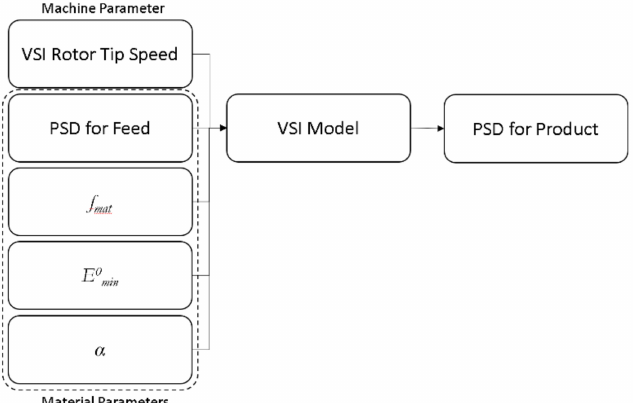
Figure 4. A model overview showing the parameters required to run the VSI crusher model at alternate speeds to predict the product PSD. The model requires a material database with f mat , E 0 min and α values obtained from previous calibration